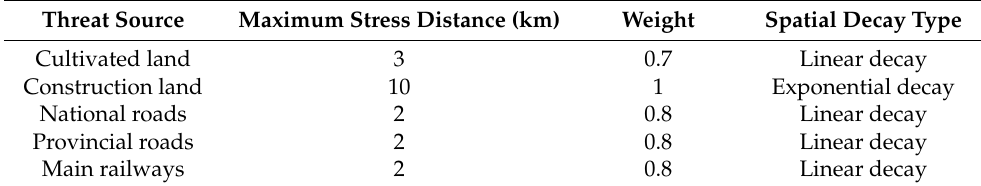
Table 3. Threat sources and their coercion